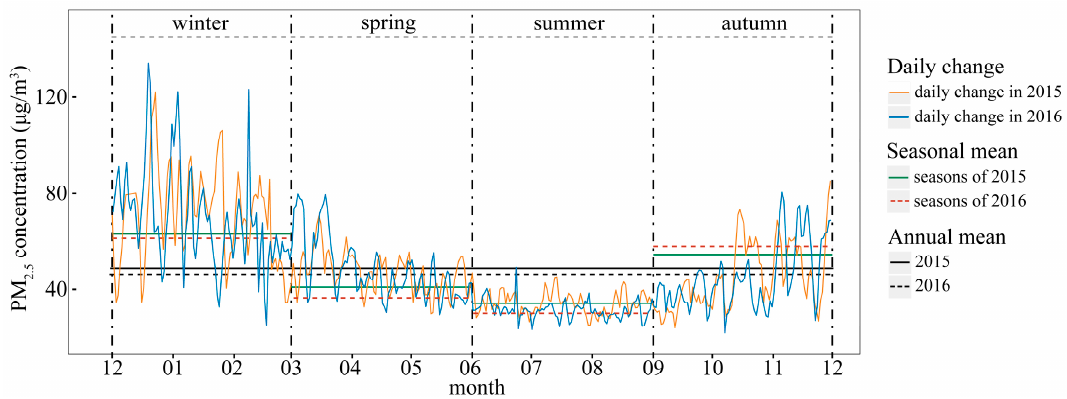
Figure 3. Variation in the PM 2.5 concentration in 2015 and 2016.